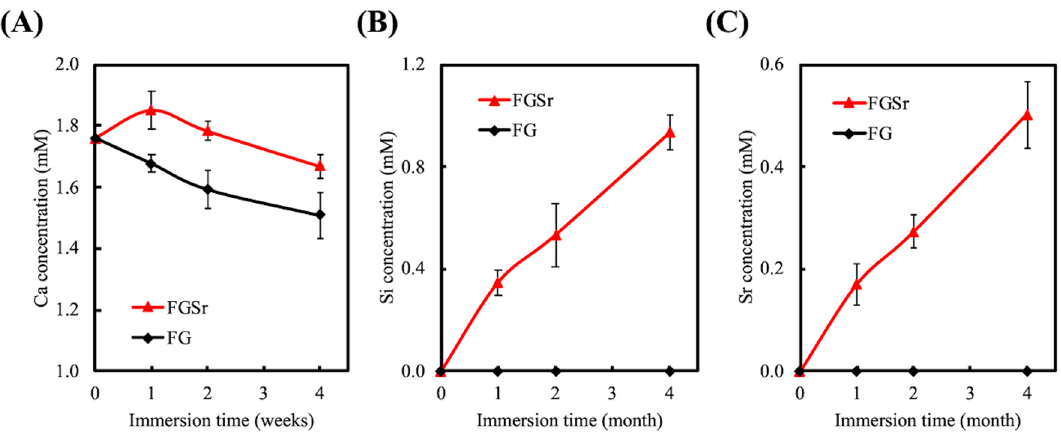
Figure 7. ( A ) Ca, ( B ) Si, and ( C ) Sr ion concentrations in SBF after immersion for different durations. Data presented as mean ± SEM, n = 6 for each group.